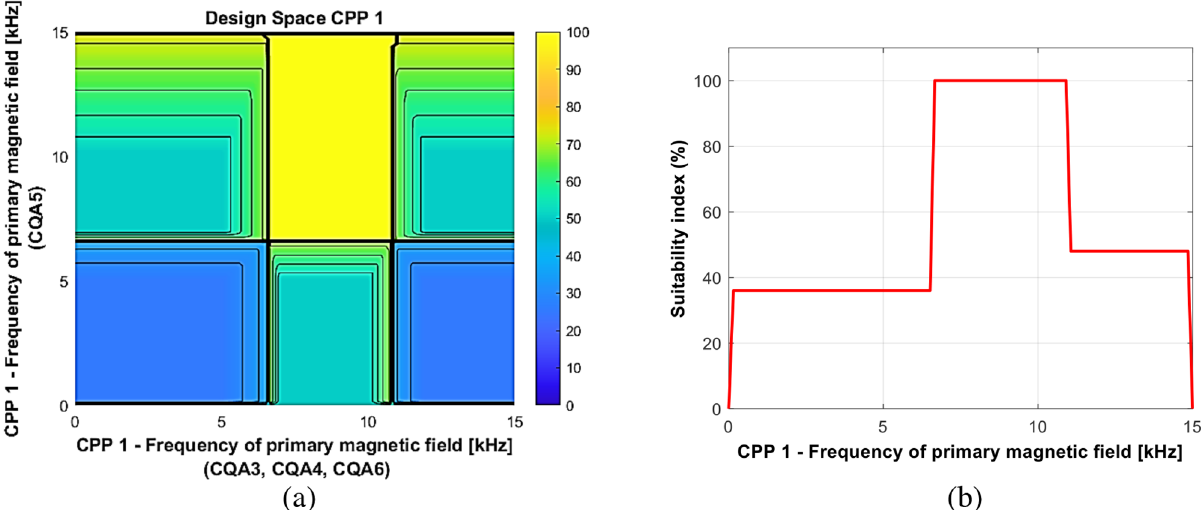
Fig. 8. Design Space map obtained for CPP 1 , in (a); range of appropriate values of CPP 1 for optimum performance of the measurement system, in (b).